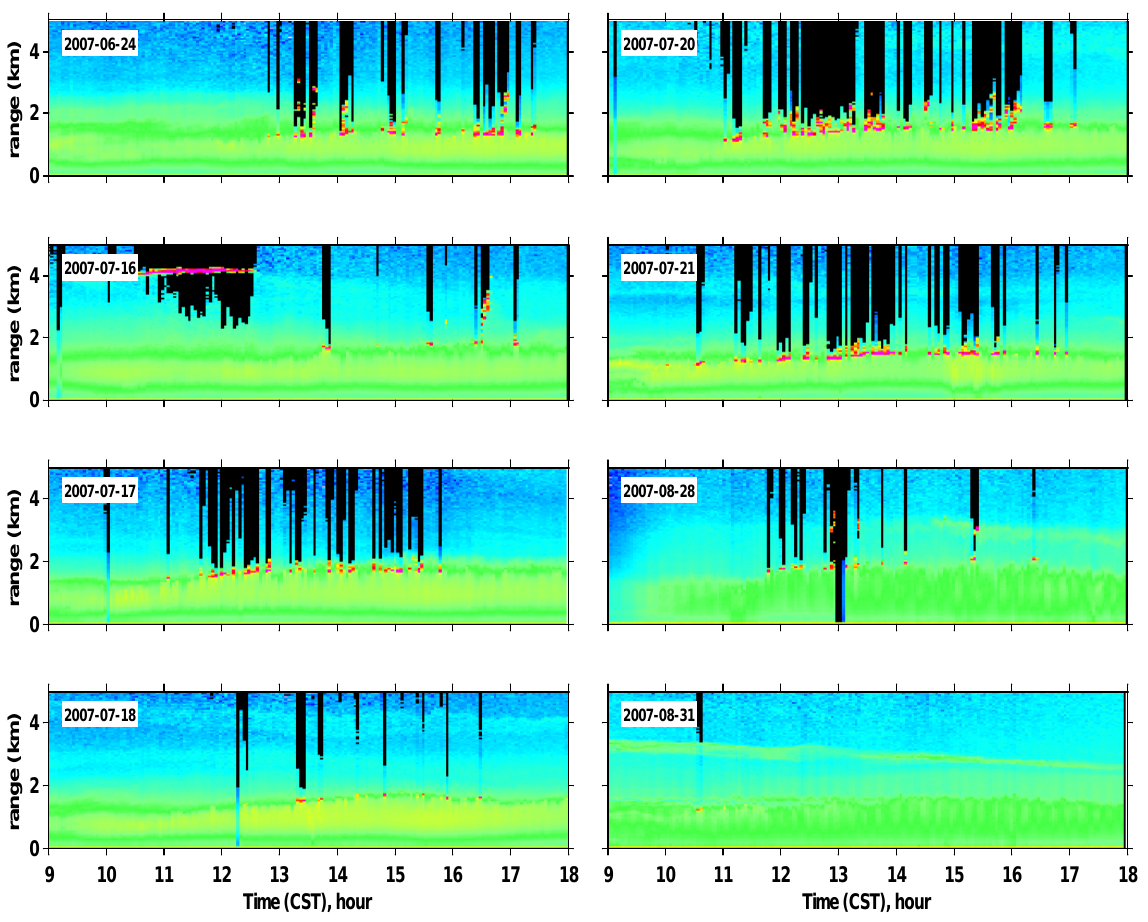
Fig. 2. Two-dimensional images of ground-based micropulse attenuated lidar backscatter for the 8 days when TSI observations are available.